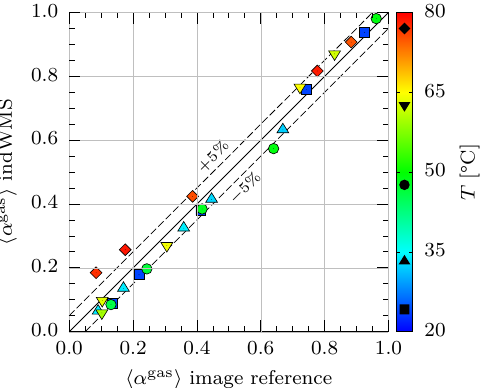
Figure 6. Comparison of cross-sectional gas phase fractions (cid:104) α gas (cid:105) obtained by the industrial wire- mesh sensor and the camera